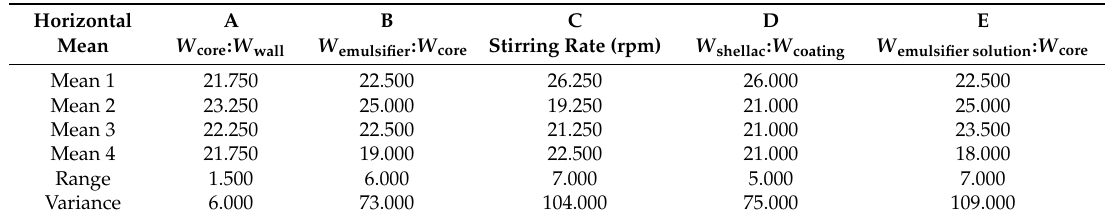
Table 5. Range and variance of the coverage rate of